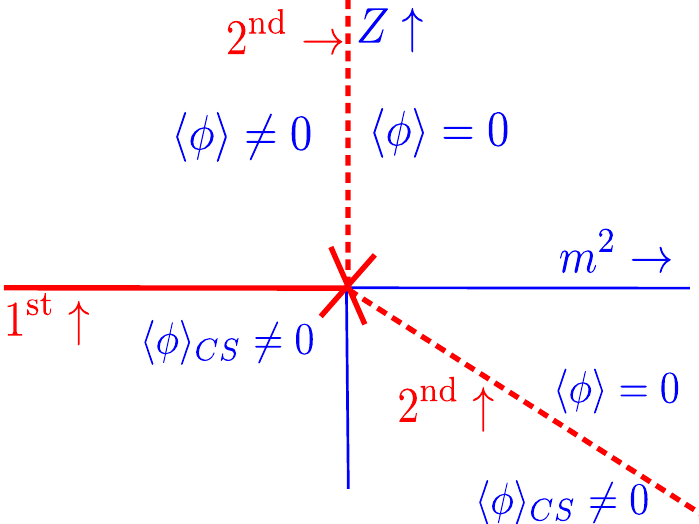
Figure 3. The phase diagram in mean field theory for a theory in which Z can be of either sign. There are three phases: symmetric, with (cid:104) φ (cid:105) = 0; broken, with (cid:104) φ (cid:105) (cid:54) = 0; and a spatially inhomogeneous phase, denoted by CS for chiral spiral. The three phases meet at the Lifshitz point, where m 2 = Z =